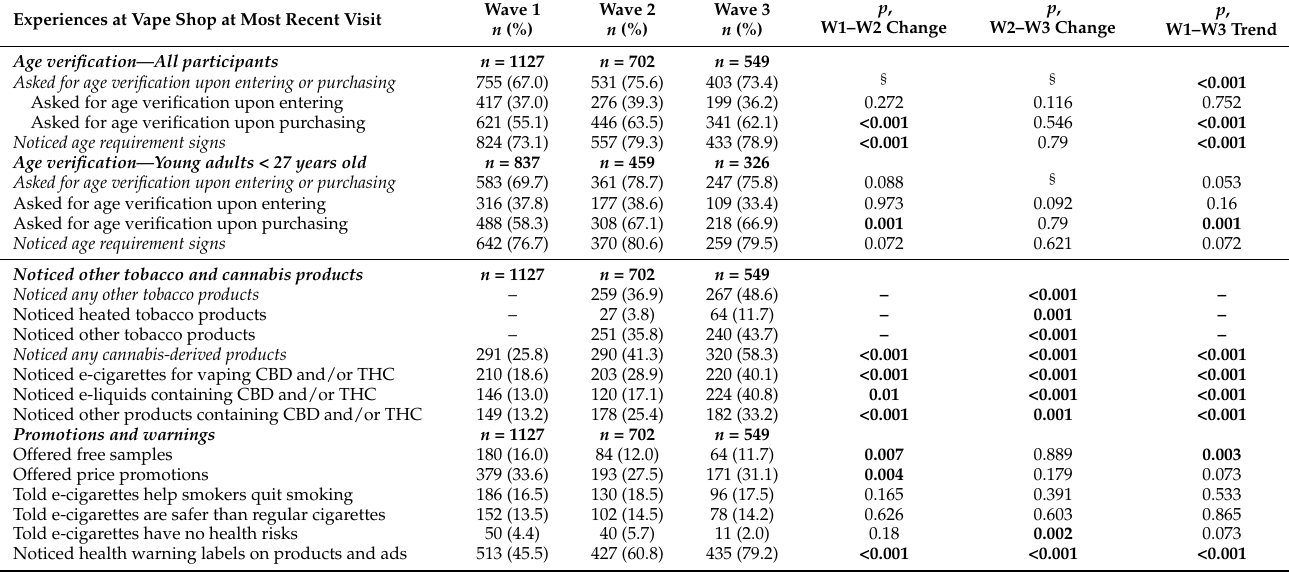
Table 3. Vape shop practices over time reported by past 6-month e-cigarette users who visited vape shops